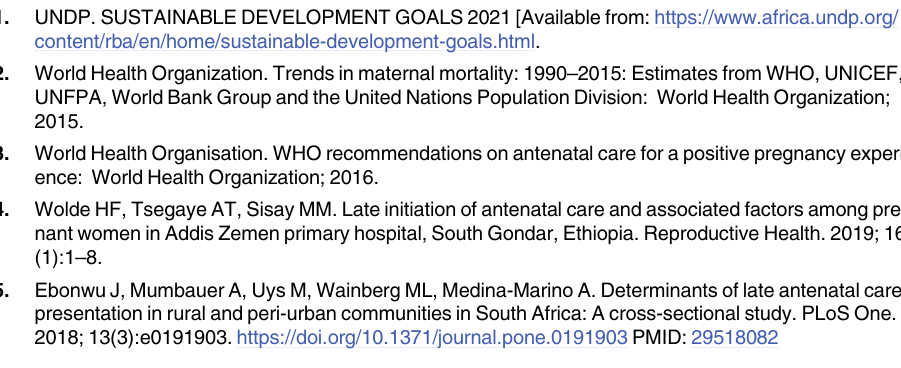
S1 Table. DHS survey data used in the study